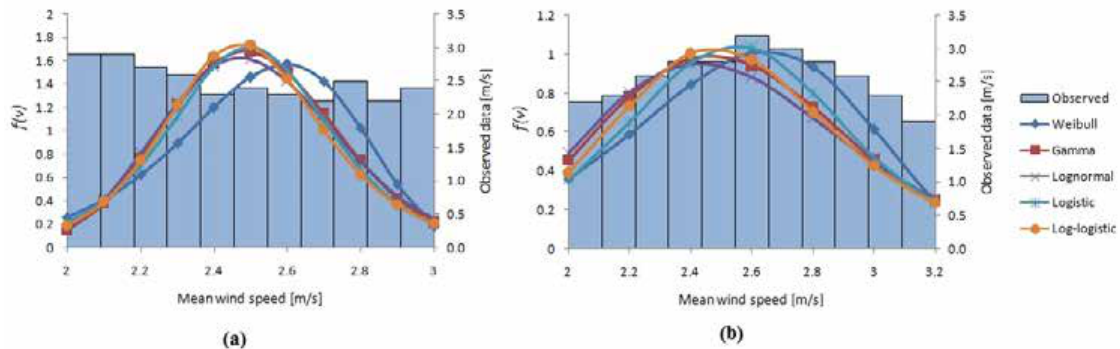
Fig. 7: Fitting pdf to the wind speed data; (a) Girne and (b) Lefkoşa Table 3: Wind speed distribution parameters for the selected regions throughout the investigation period and the selected distribution ( in bold ) for each region using the maximum likelihood method. Weibull Gamma Log-normal Observed Region Mean c Mean Mean data [m/s] k [m/s] [m/s] [m/s] [m/s] 𝛍𝛍 𝛔𝛔 Girne 𝛃𝛃 𝛏𝛏 93.689 Logistic Log-Logistic Observed Region Mean data [m/s]